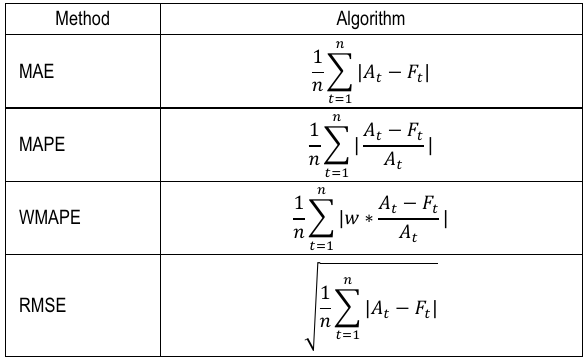
Table 2. Performance measurement